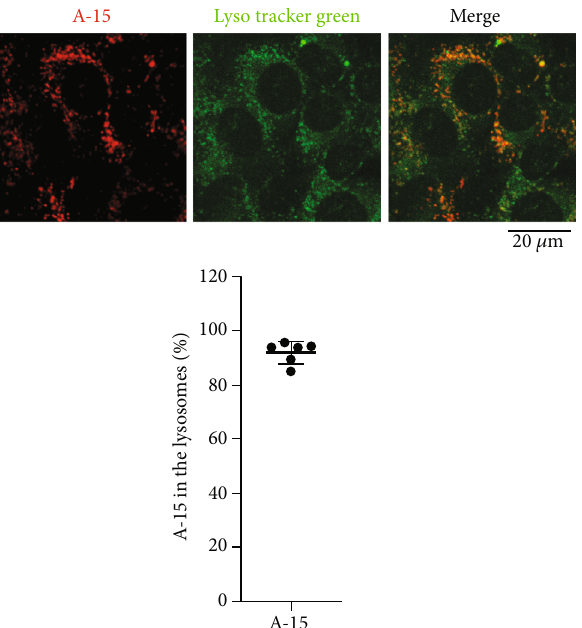
Figure 1: Subcellular location of incorporated naked A-15. After 24-hour culture in the presence of naked Alexa568-labeled A-15 (500nM), MEFs were rinsed with PBS, and fl uorescence images from Alexa568 and LysoTracker Green were visualized using a confocal microscope. Colocalization rates were quanti fi ed with ImageJ. Error bars indicate s.d. ( n = 6